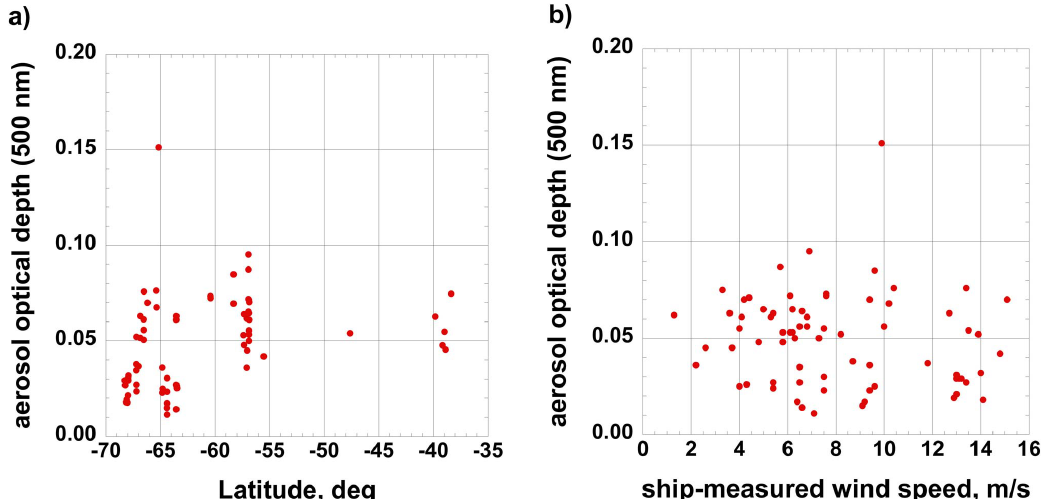
Fig. 1. Latitudinal dependence of AOD series acquired at least 200km from the nearest landmass (a) , and AOD dependence on ship-based wind speed (b) during the February–April 2008 cruise of the R/V Polarstern